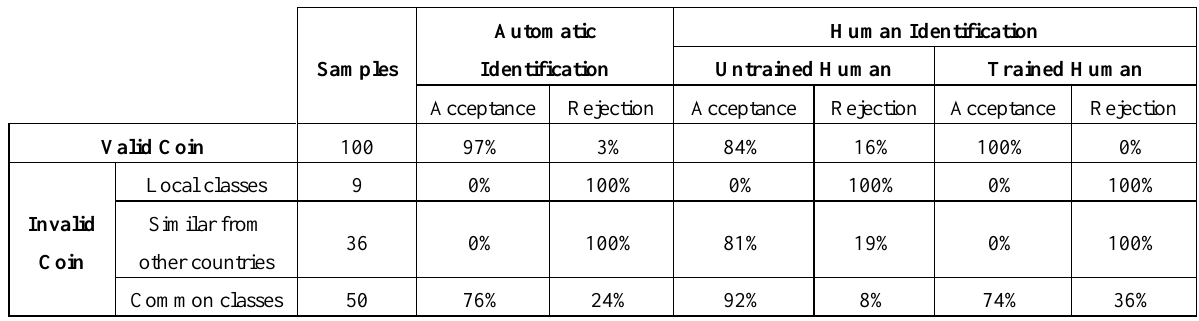
Table 2. Validation comparative